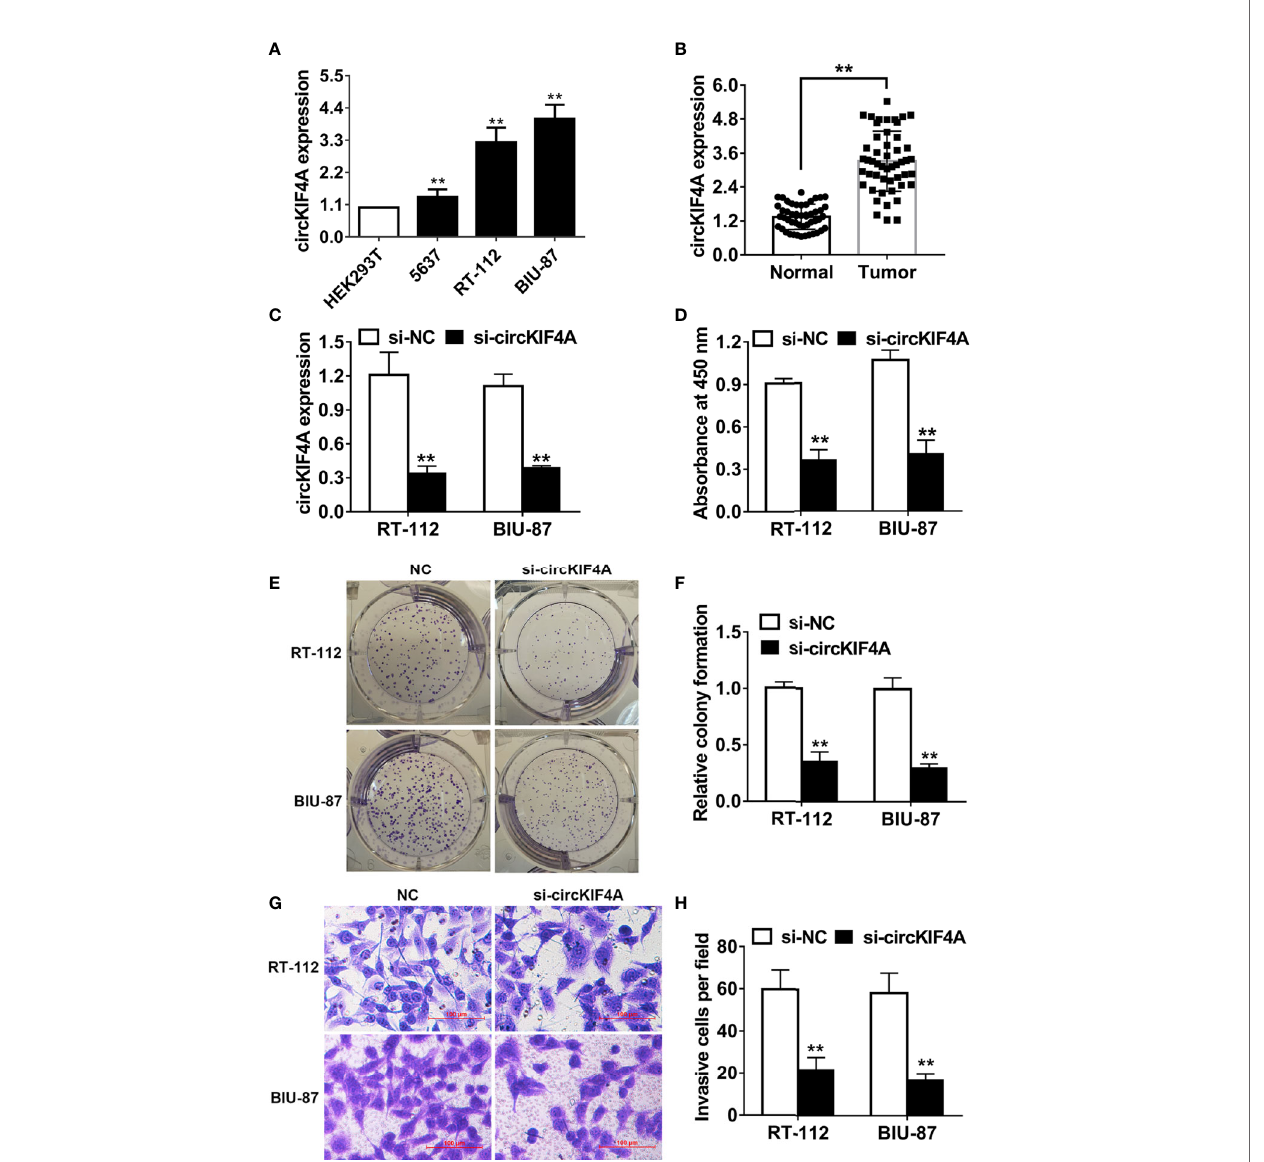
FIGURE 1 | circKIF4A promotes bladder cancer growth and metastasis in vitro. (A) The relative expression level of circKIF4A in bladder cancer cell lines. (B) The expression level of circKIF4A was validated in 50 paired bladder cancer and adjacent normal tissues. (C) The knockdown of circKIF4A was assessed by qRT-PCR. (D) CCK-8 assay was conducted to detect cell proliferation. (E, F) Colony formation assays were conducted. (G, H) Inhibition of circKIF4A reduced the invasion ability in the transwell assay. **P <